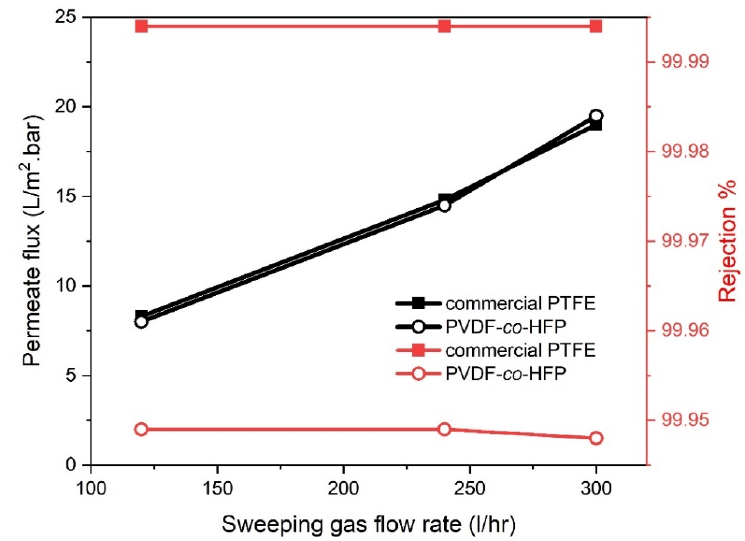
Figure 7. Effect of sweeping gas flow rate on permeate flux and salt rejection at 65 °C feed temperature, 0.6 feed flowrate and 35 g/L feed concentration for PTFE and PVDF-co-HFP